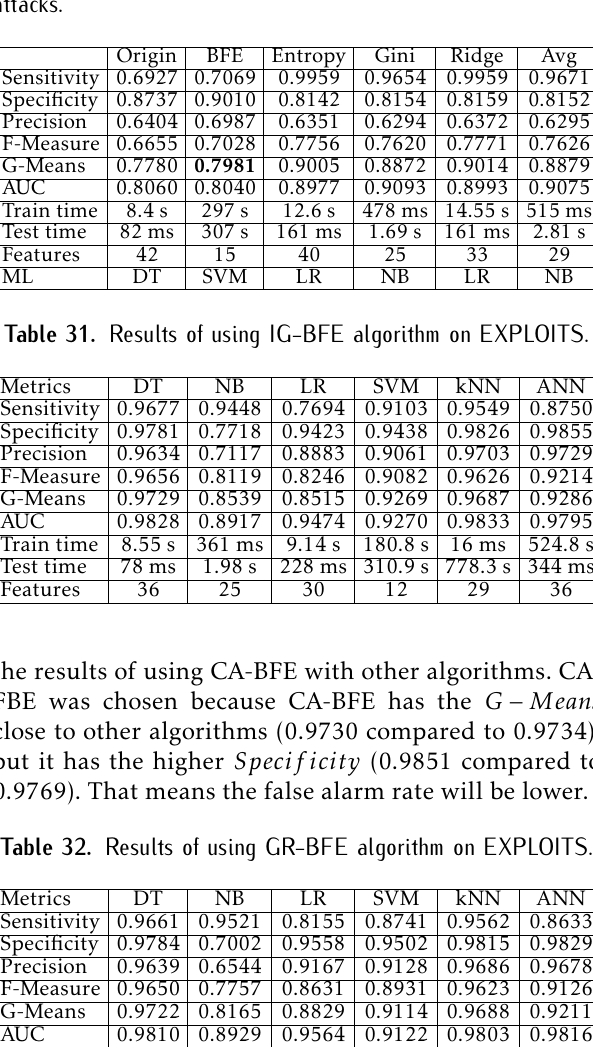
Table 26. Compare GR-BFE with other algorithms on DOS.